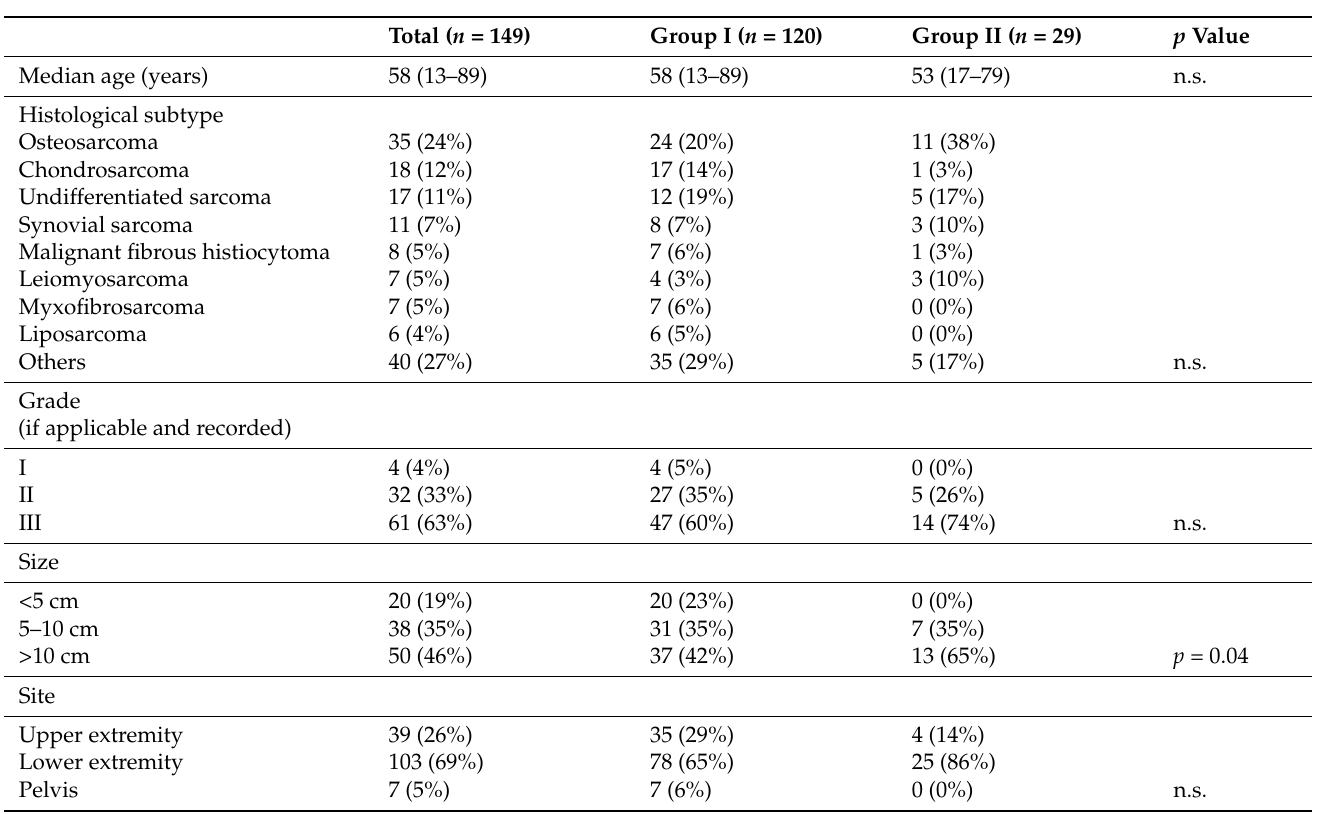
Table 2. Demographic data, tumor characteristics and anatomic amputation levels. Age (range in brackets), else percentage in